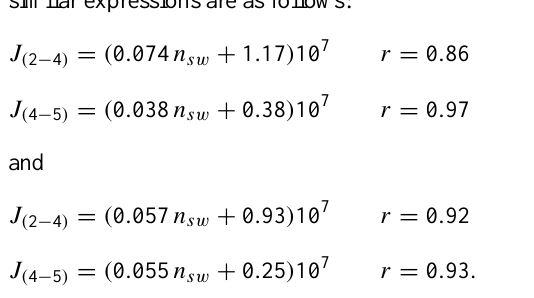
the linear approximation of experimental points.